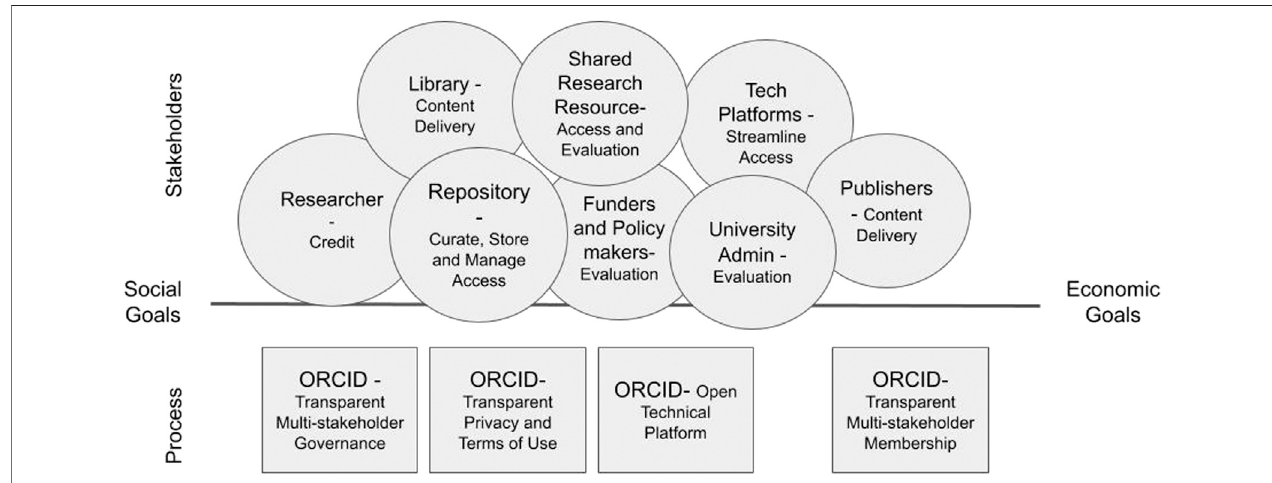
FIGURE 3 | Like GA4GH, ORCID has been a multi stakeholder initiative from its founding. It started with a practical solution, and built adoption by engaging iteratively with stakeholders, developing trust through transparent processes and demonstrating value and mutual social and economic bene fi t.